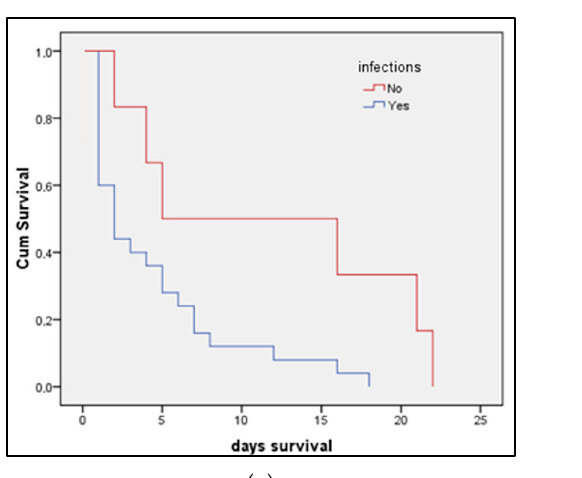
Figure 3. ( a , b ) Kaplan–Meier plots of preterm newborn survival (in days) from mothers with preeclampsia or thrombophilia compared with newborns from mothers without preeclampsia or thrombophilia.